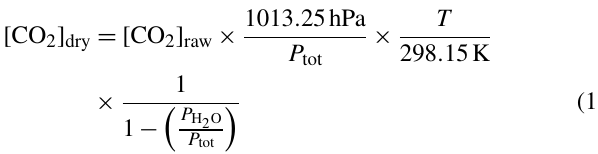
Figure 4. Current BEACO 2 N node